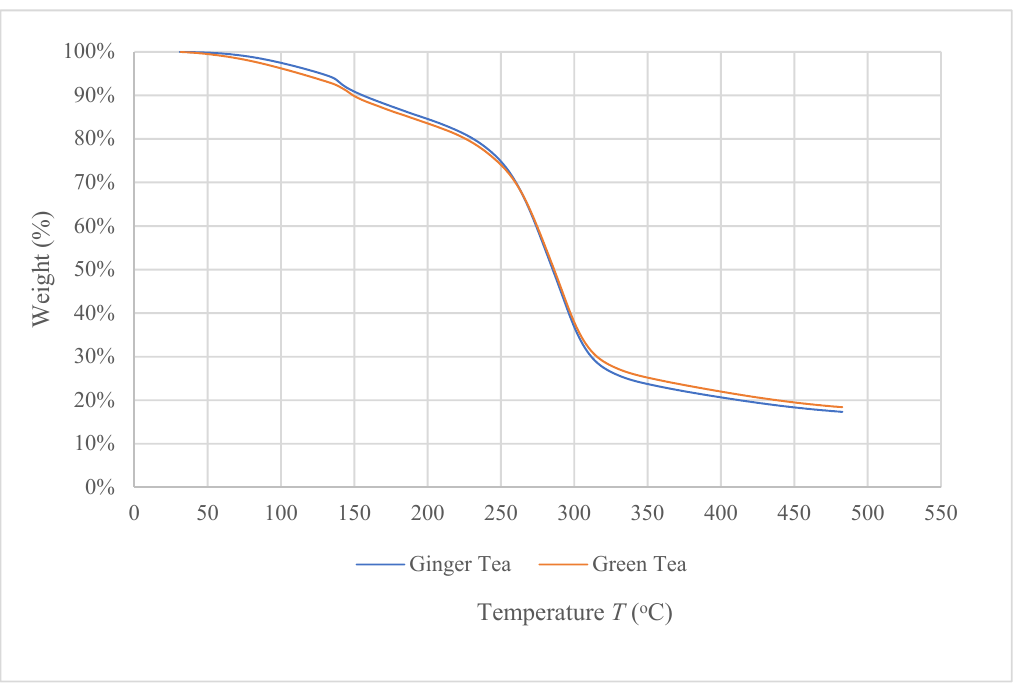
Figure 6. TGA analysis curve of the prepared bioplastic samples.